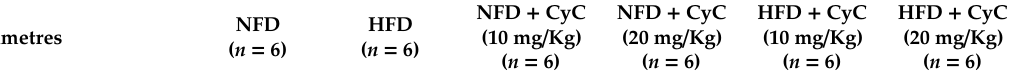
Table 1. The e ff ect of Cynara Cardunculus extract (CyC) (10 and 20 mg / kg daily given orally over a period of four weeks) on serum glucose (mg / dL), total cholesterol (mg / dL), triclycerides (mg / dL), SteatoTest (ST score) and MDA (nm / µ l) in NFD and HFD. Data are expressed as mean ± SE. NFD + NFD HFD Parametres ( n = 6) ( n = 6)